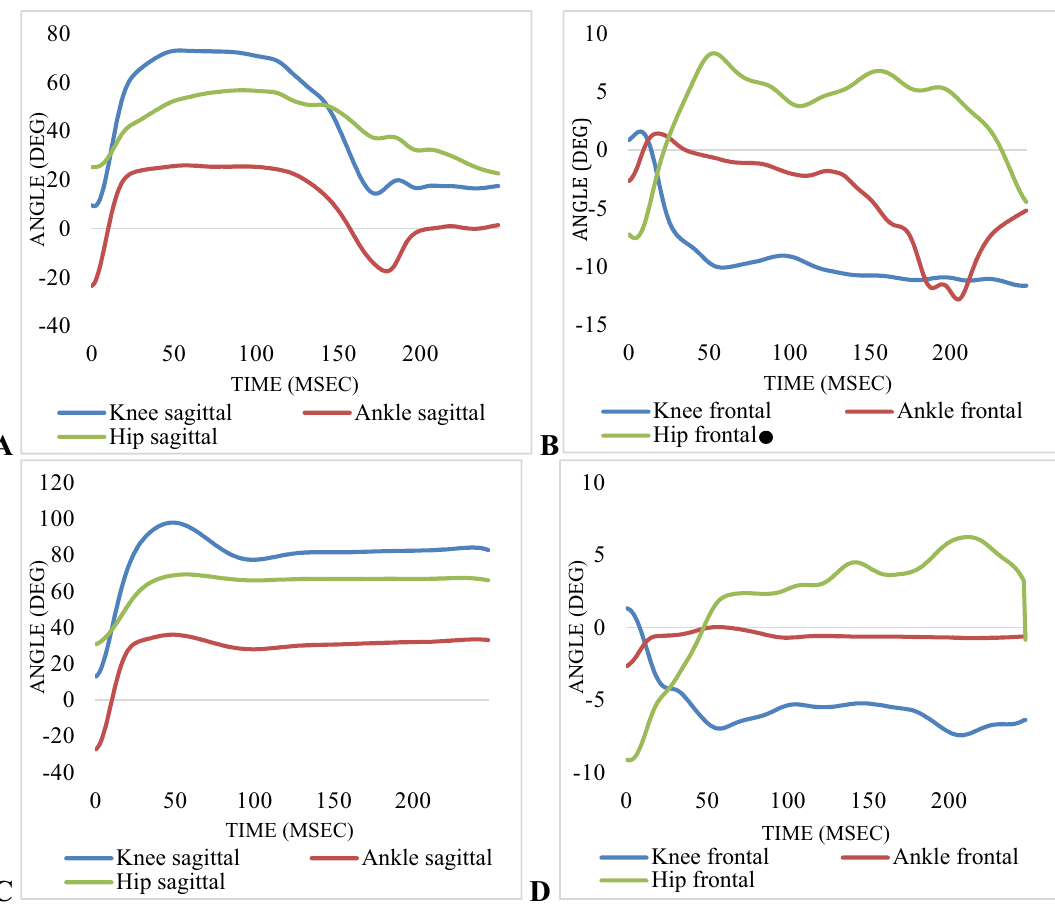
Figure 2. ( A ) Angle curves of knee, ankle, and hip joints from IC to TL phases: ( A ) in sagittal motion plane during SLL, ( B ) in frontal motion plane during SLL, ( C ) in sagittal motion plane during DLL, ( D ) in frontal motion plane during DLL. (+ values = flexion, dorsiflexion, adduction/− values = extension, plantar flexion, abduction)/ = Significant correlation observed between hip adduction angle and DKV angle during SLL (P = 0.043, R = 0.327).